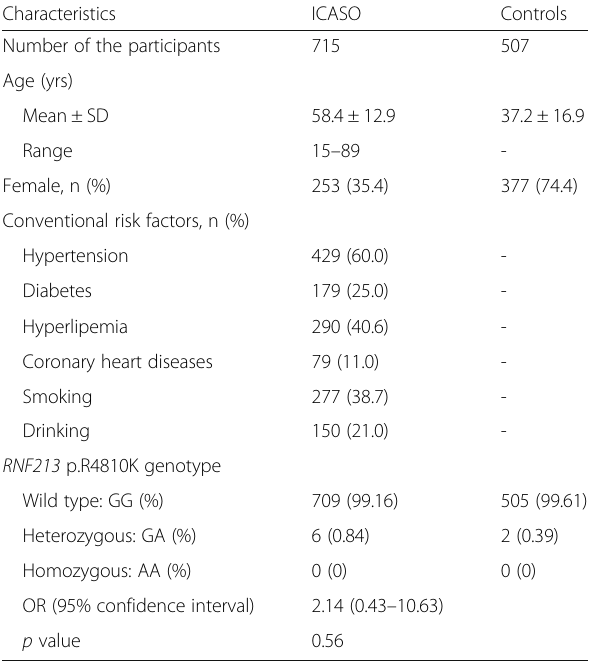
Table 1 Characteristics of the participants and distribution of the RNF213 p.R4810K variant